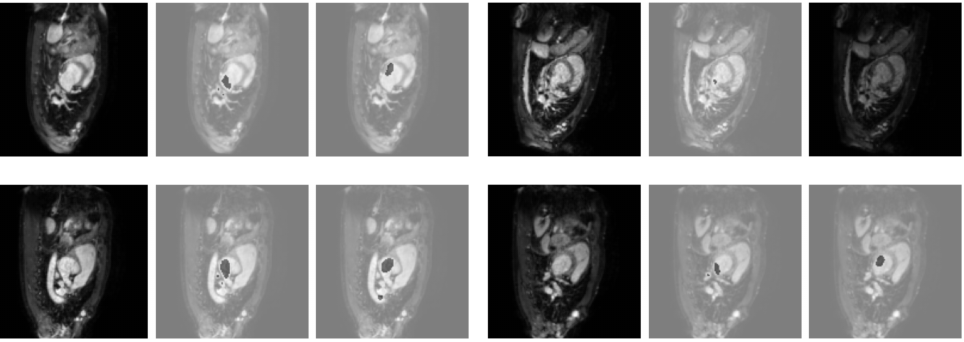
Figure 8. Examples of misclassified heart images. From left to right: original image, ground truth, and